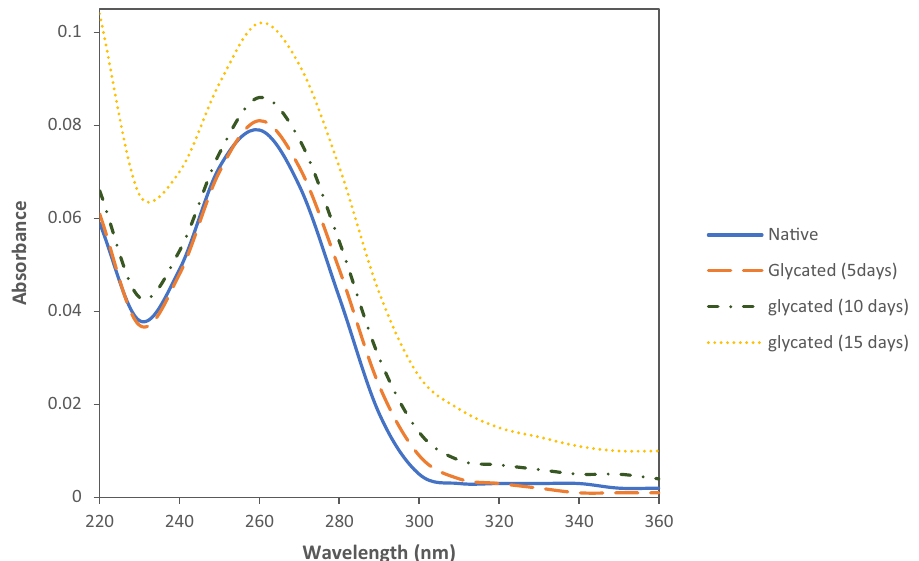
Figure 1. UV absorption of the Native DNA (–) and DNA incubated with fructose 25 mM, after 5 (---), 10 (-.-.) and 15 days (….).